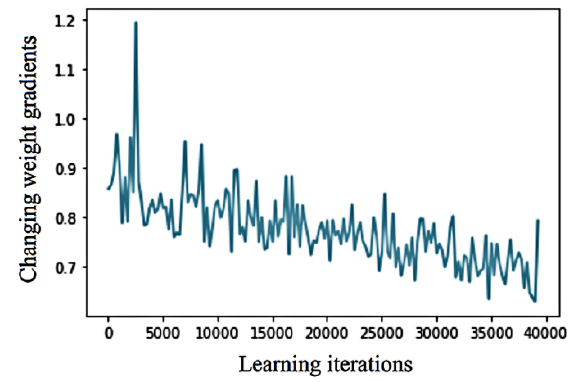
Fig. 4. Graph of decreasing changes in the gradients of weights of an artificial neural network .